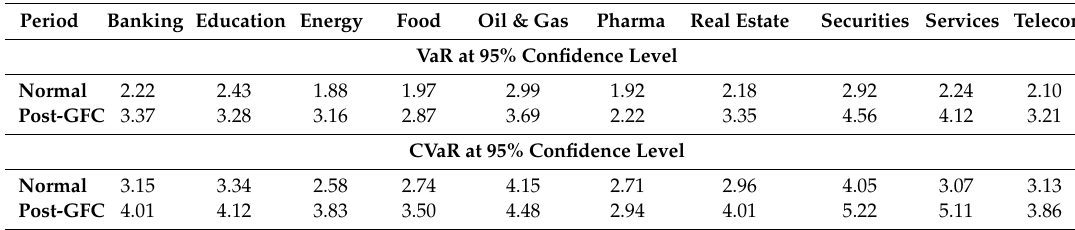
Table 2. Sub-sample mean VaR and CVaR at 95% confidence, 2009–2017.